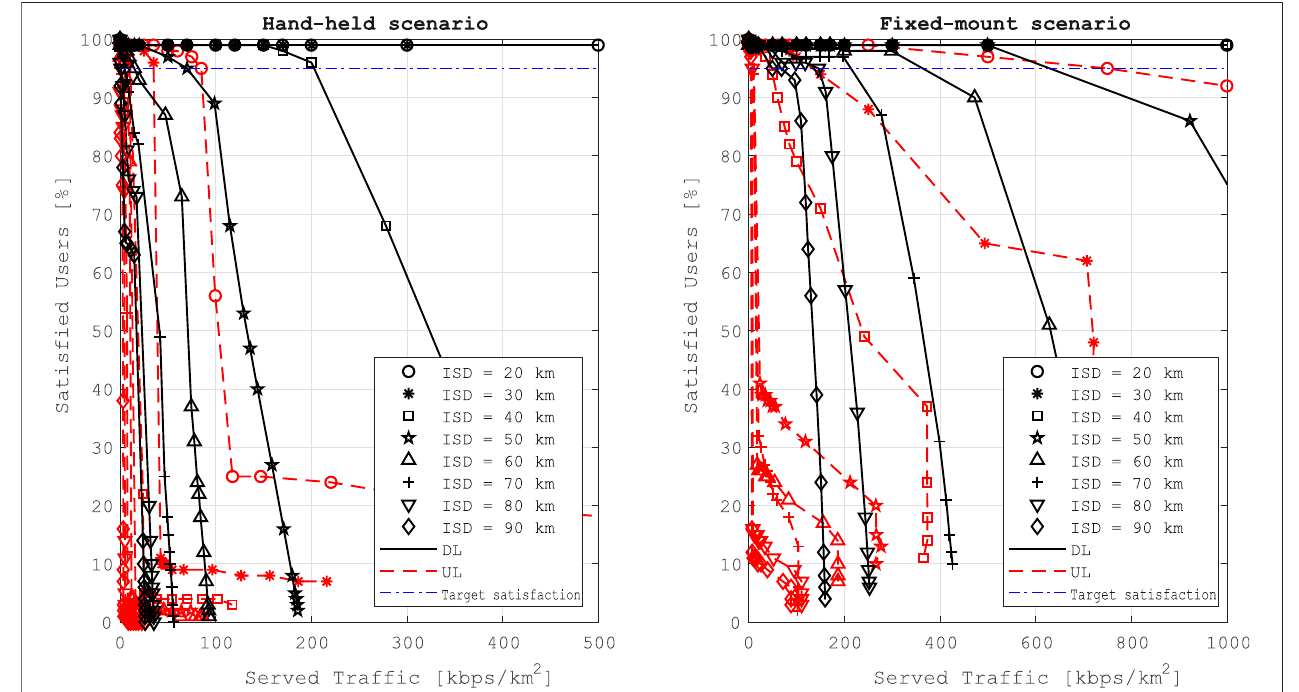
FIGURE 5 | User throughput as function of served traf fi c per macro cell, corresponding to 95% coverage.